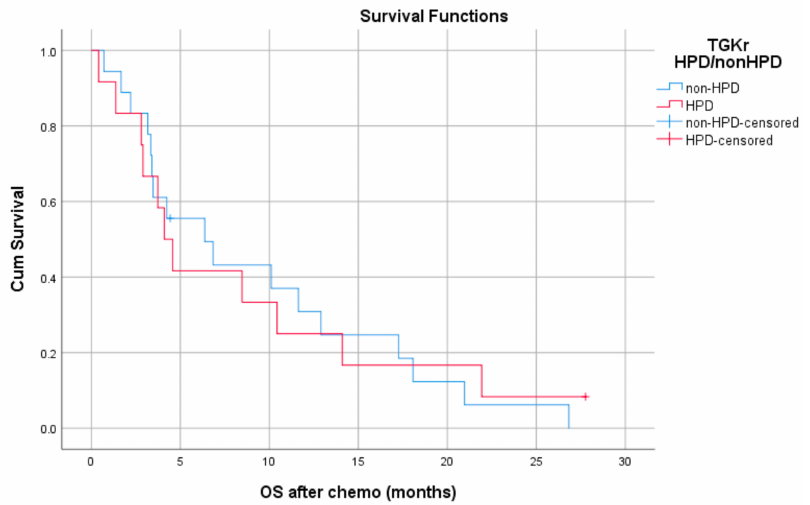
Figure 5. Association of type of progressive disease (HPD vs. non-HPD) with OS of chemotherapy after immunotherapy failure (OS chemo).